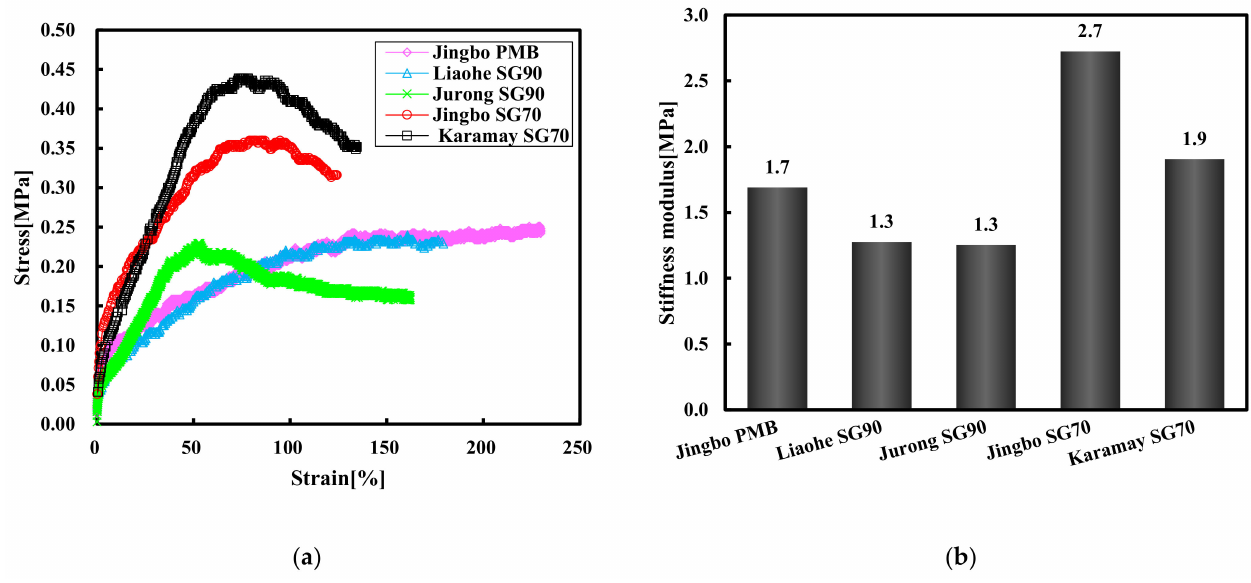
Figure 9. Tensile stress–strain curve ( a ) and stiffness modulus ( b ) of five bitumen binders at 0 ◦